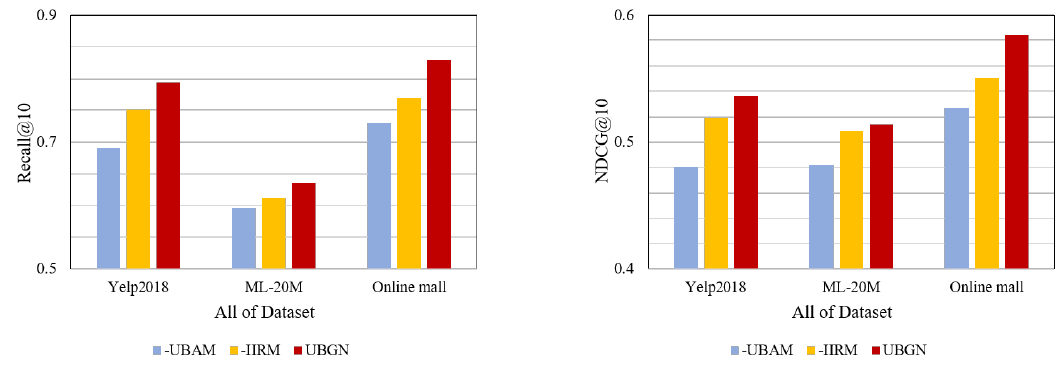
Figure 3. Results of ablation experiments of sub-modules in